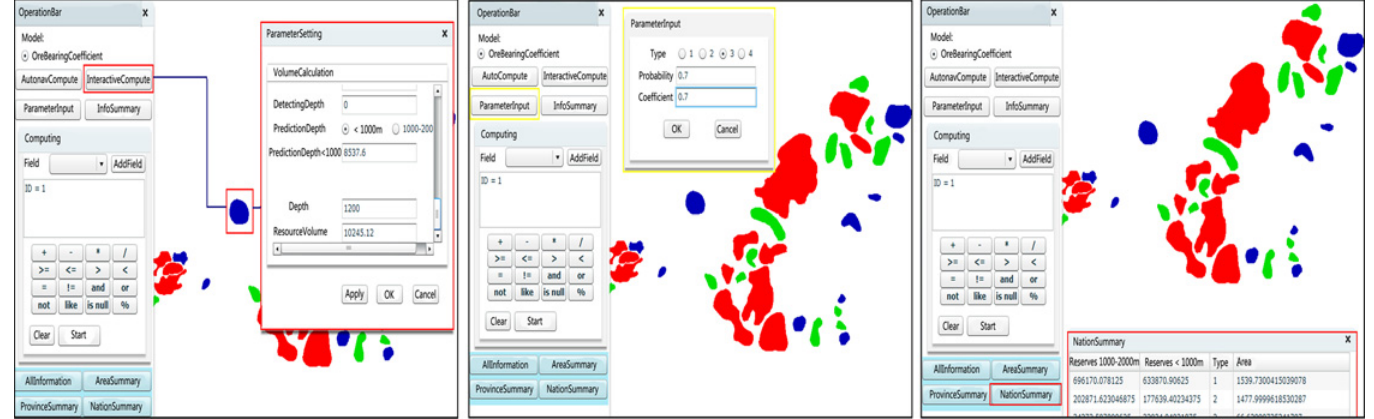
Fig 16. Iron mine potential evaluation on the GSICCP.